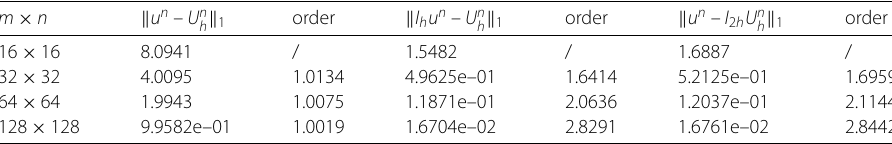
Table 6 Numerical results of u at t = 1 m ×